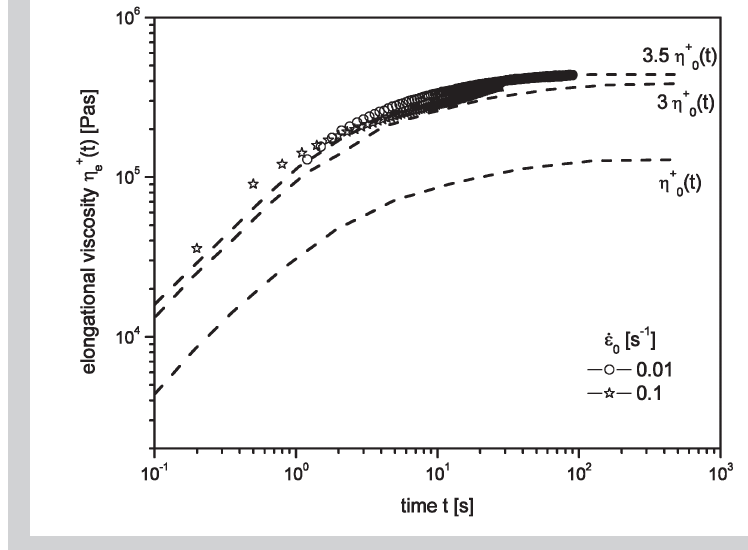
Figure 12: Transient elongational and shear viscosity of PS / 4.8 vol% nano-clay at